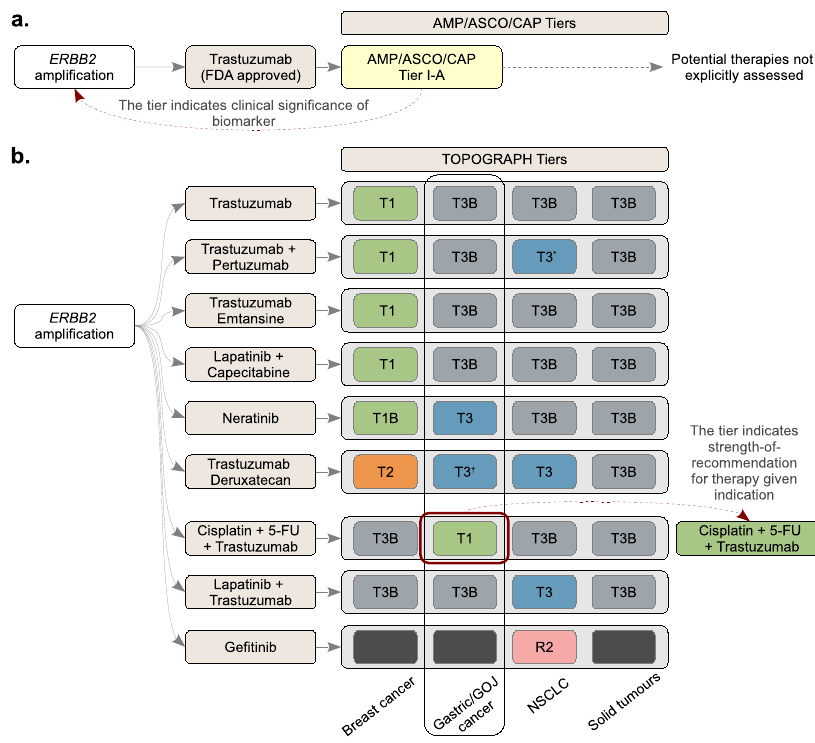
Fig. 4 Comparison of therapy- and biomarker-focused-tiering approach. A schematic diagram comparing the two different tiering approaches. a In a biomarker-focused approach (e.g., AMP/ASCO/CAP system), a tier is assigned to a molecular alteration to indicate its clinical signi fi cance; complete list of therapies is not explicitly assessed. b In contrast, TOPOGRAPH — which uses a therapy-focused approach to review literature — assigns a tier to each therapy (instead of a biomarker) to indicate the strength-of-recommendation based on